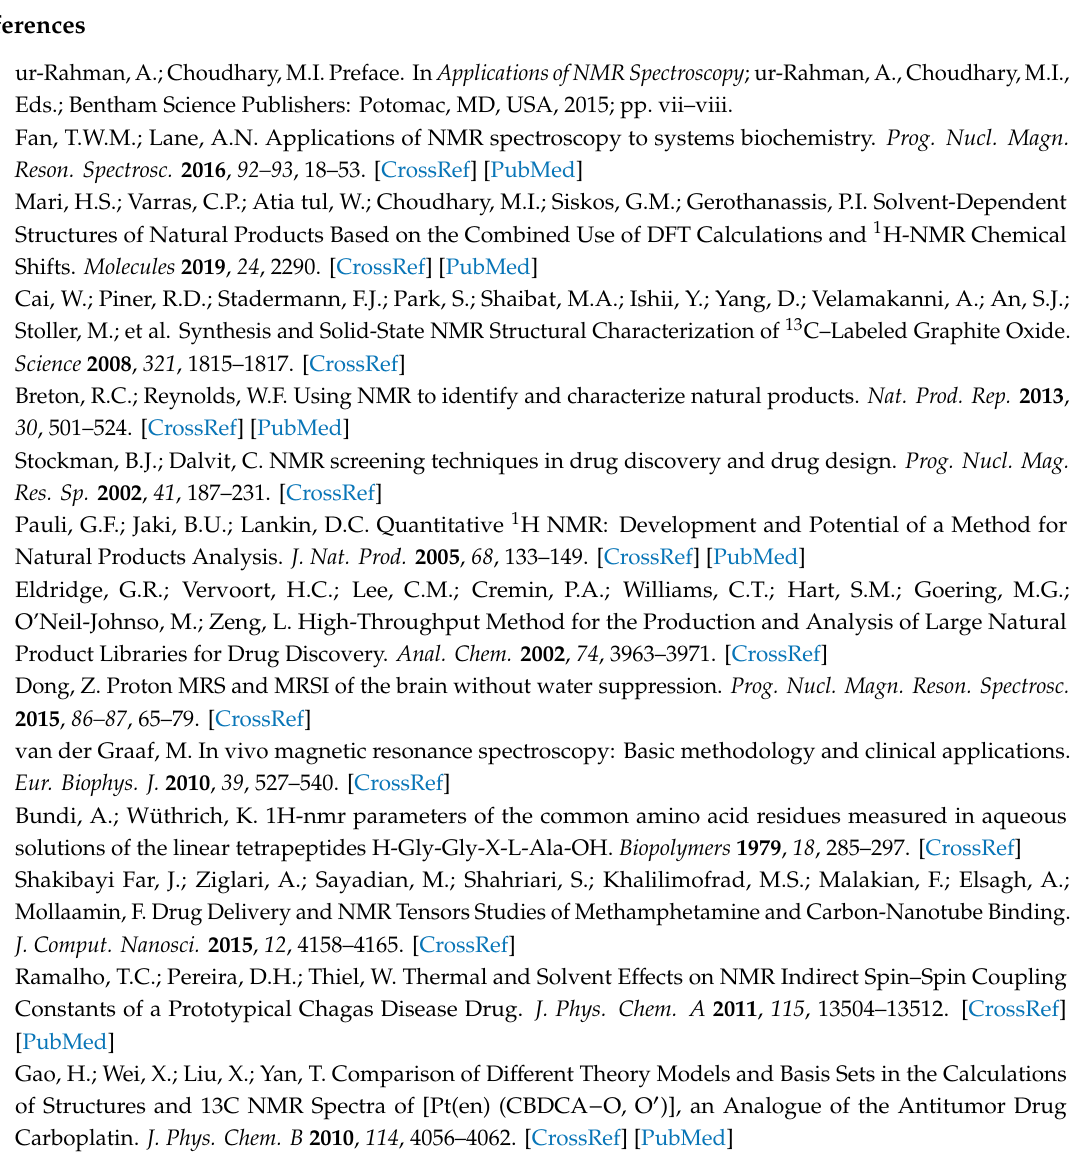
Supplementary Materials: The following are available online: Figure S1: PCM and SMD modelled gas-to-liquid energy di ff erences for uracil and its 5XU tautomers vs. their dipole moments in vacuum, Figure S2: Three tautomers of N-formylformamide with overlapped maps of electrostatic potential and total dipole moment indicated, Table S1: Values of NICS and HOMA aromaticity indexes for uracil tautomers and its 5-halogen derivatives in the gas phase and water (PCM and SMD) calculated at B3LYP-D3 / 6-31 + G(d,p) level of theory, Table S2: Deviations from experiment of B3LYP calculated chemical shifts (in ppm) with STO(1M)-3G, 6-311 + G(2d,p) and aug-cc-pVQZ basis sets for uracil tautomer 1 in the gas phase and water a . Separate RMS values for selected nuclei are shown, Table S3: Deviations from experiment of B3LYP calculated chemical shifts (in ppm) with STO(1M)-3G, 6-311 + G(2d,p) and aug-cc-pVQZ basis sets for 5FU tautomer 1 in the gas phase and water a . Separate RMS values for selected nuclei are